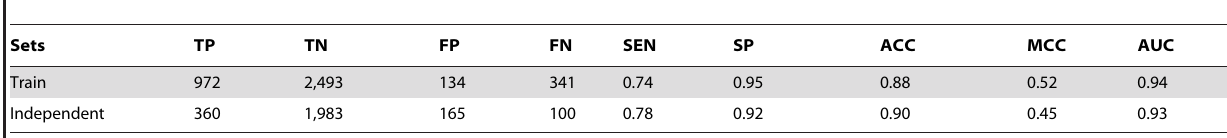
Table 1. Classification performance by the trained classifier on the training and an independent test set.